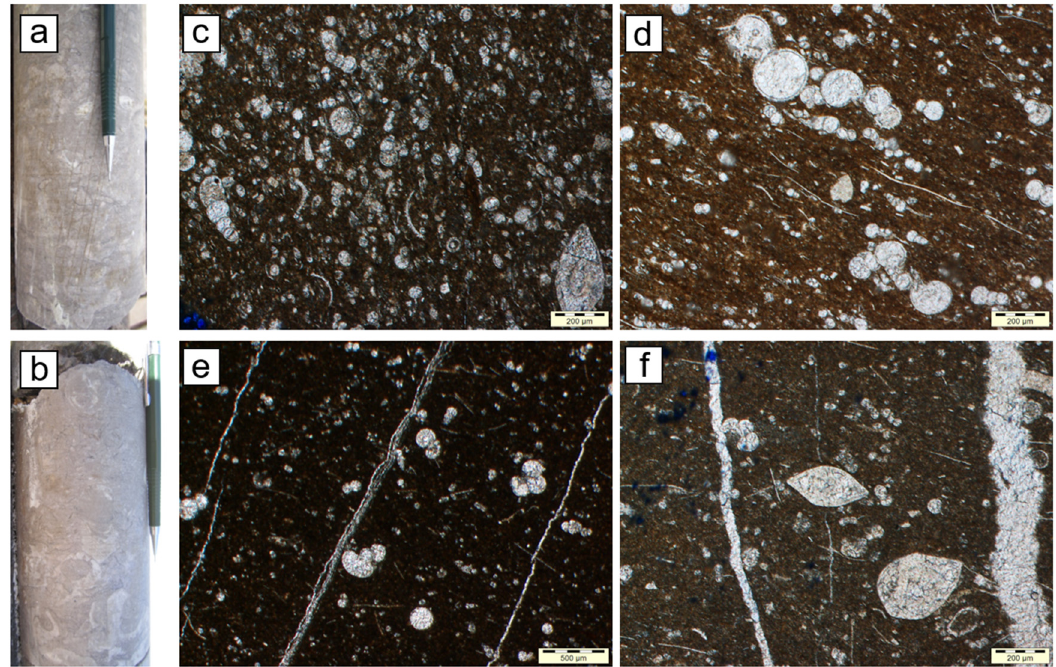
Figure 3. ( a , b ) cores of the Turonian carbonate interval taken from Well-1, at depths 1706 m and 1734 m, respectively; thin section petrography indicating ( c , d ) planktic foraminiferal wackestone- packstone with fragmented bivalves, dominated by micrite matrix (brown/dark brown colored); ( e , f ) planktic foraminiferal wackestone, with scattered planktic foraminiferas, matrix-dominated fractures-filled with calcite cement.